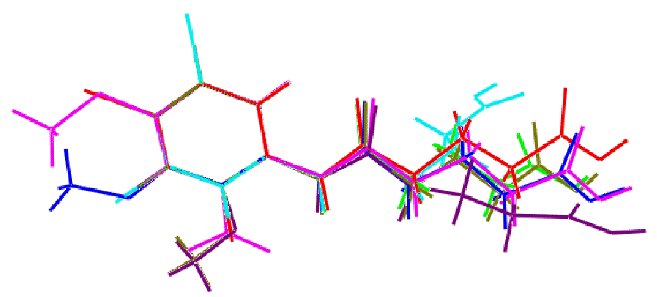
Figure 3. Overlay diagram of molecules related to ( 1 ): ( 1 ), red image; Ar = 4-ClC 6 H 4 , green; 3- MeOC 6 H 4 , blue; 2-MeOC 6 H 4 , first independent molecule, purple; 2-MeOC 6 H 4 , second independent molecule, olive green; 3,5-Cl 2 C 6 H 3 , cyan; and 2-NO 2 , 4-OMeC 6 H 3 , pink. The molecules have been overlapped so the phenyl rings are coincidental and the amide functionalities are approximately aligned.